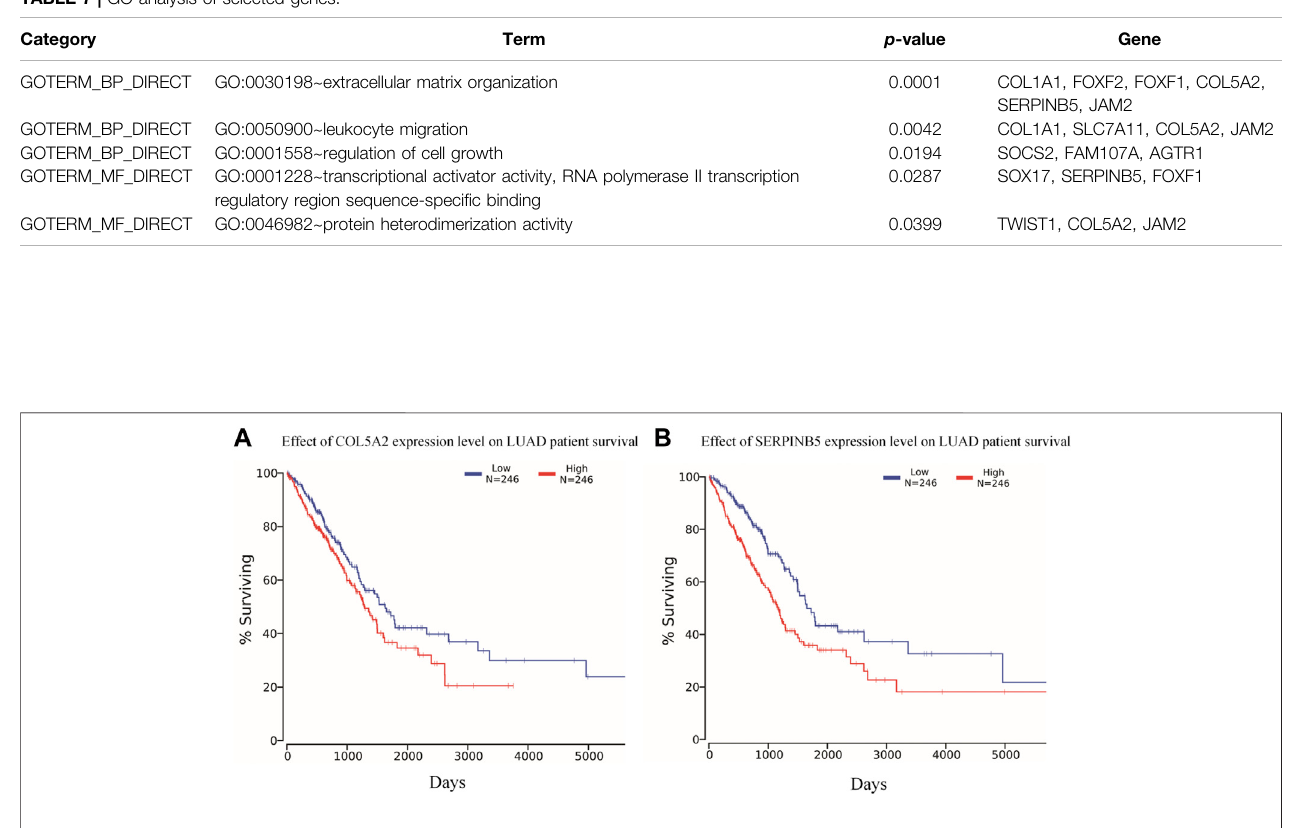
FIGURE 7 | Overall survival analysis in LUAD based on the TCGA data as determined by Kaplan-Meier estimates. (A) COL5A2 and (B) SERPINB5 are signi fi cantly affect the prognosis of LUAD in overall survival ( p < 0.05).